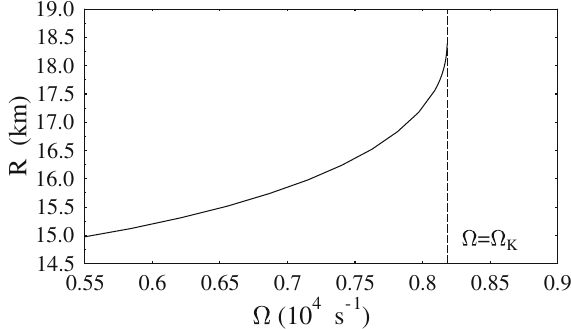
Fig. 1 The radius R of a uniformly rotating star increases sharply as the Kepler (mass-shedding) limit ( Ω = Ω K ) is approached. The particular sequence of models shown here has a constant central energy density of (cid:19) c = 1 . 21 × 10 15 g cm − 3 and was constructed with EOS L. (Image reproduced with permission from Stergioulas and Friedman 1995, copyright by AAS)